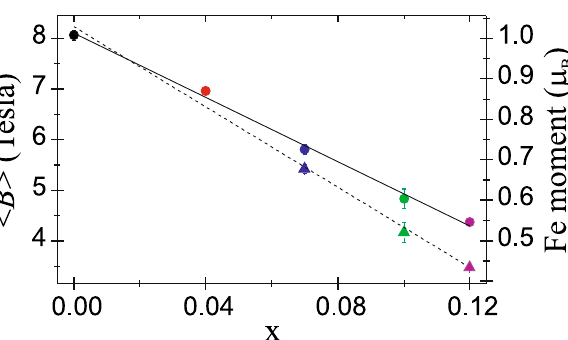
Figure 6. The average hyperfine field of SDW < B > at 4.2 K and corresponding itinerant magnetic moment versus Ni-substitution level x for EuFe 2−x Ni x As 2 system. Triangles represent the weighted average values of both quantities with taking into account the contribution of SDW